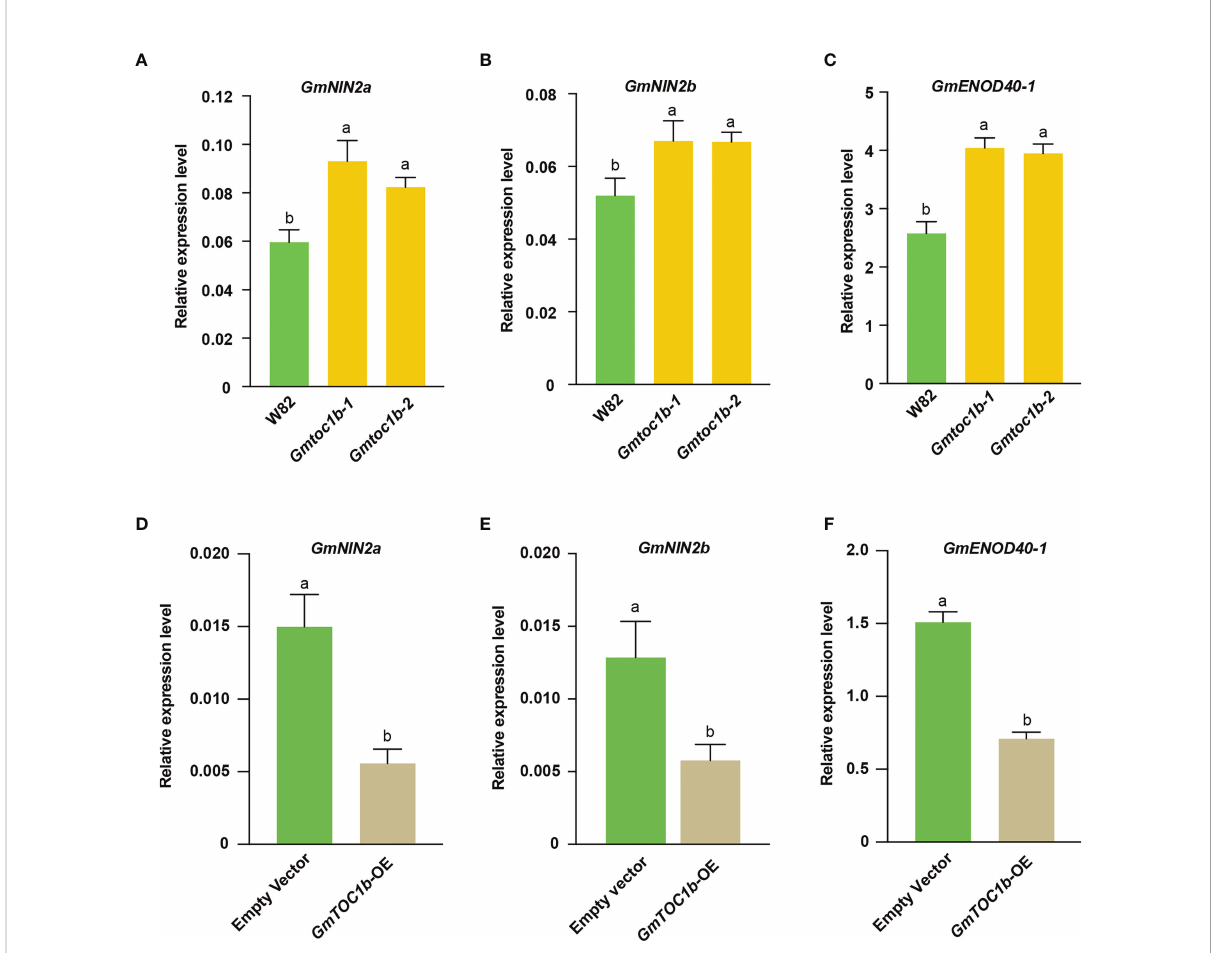
FIGURE 5 Expression of key nodulation-related genes in the early stage of rhizobia inoculation. Roots were harvested for analysis at 3 DAI. (A – C) Relative transcript levels of GmNIN2a , GmNIN2b , and GmENOD40-1 in the roots of W82 and Gmtoc1b mutants. (D – F) Relative transcript levels of GmNIN2a , GmNIN2b , and GmENOD40-1 in the roots of GmTOC1b- OE and empty vector control transgenic hairy roots. Relative expression level was calculated as the ratio of the expression value of the target gene to that of reference gene GmActin as an internal standard. Three biological replicates were performed in all experiments. Different lowercase letters indicate signi fi cant differences as determined by Student ’ s t